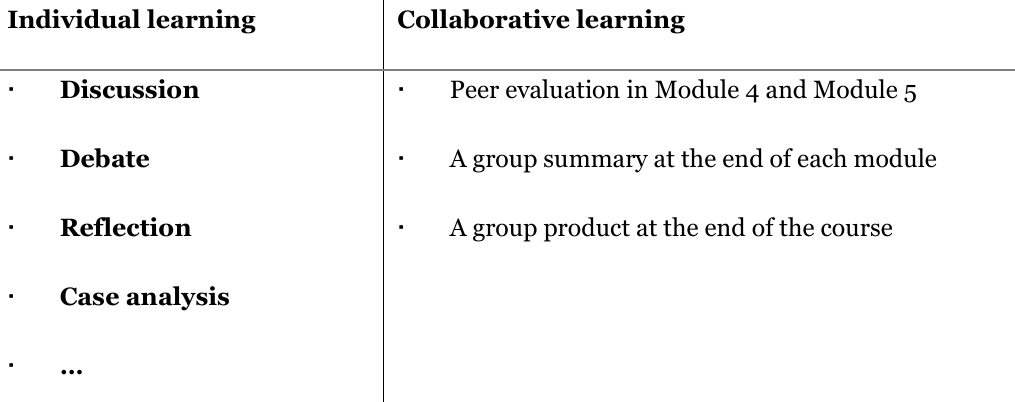
Individual and Collaborative Learning Activities Individual learning